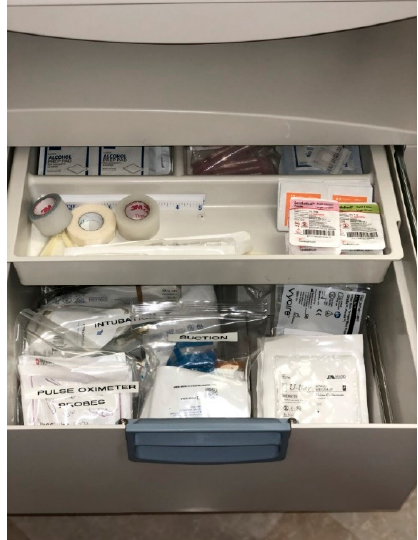
Figure 4. Mother–Baby Radiant Warmer Drawer After Simulation.